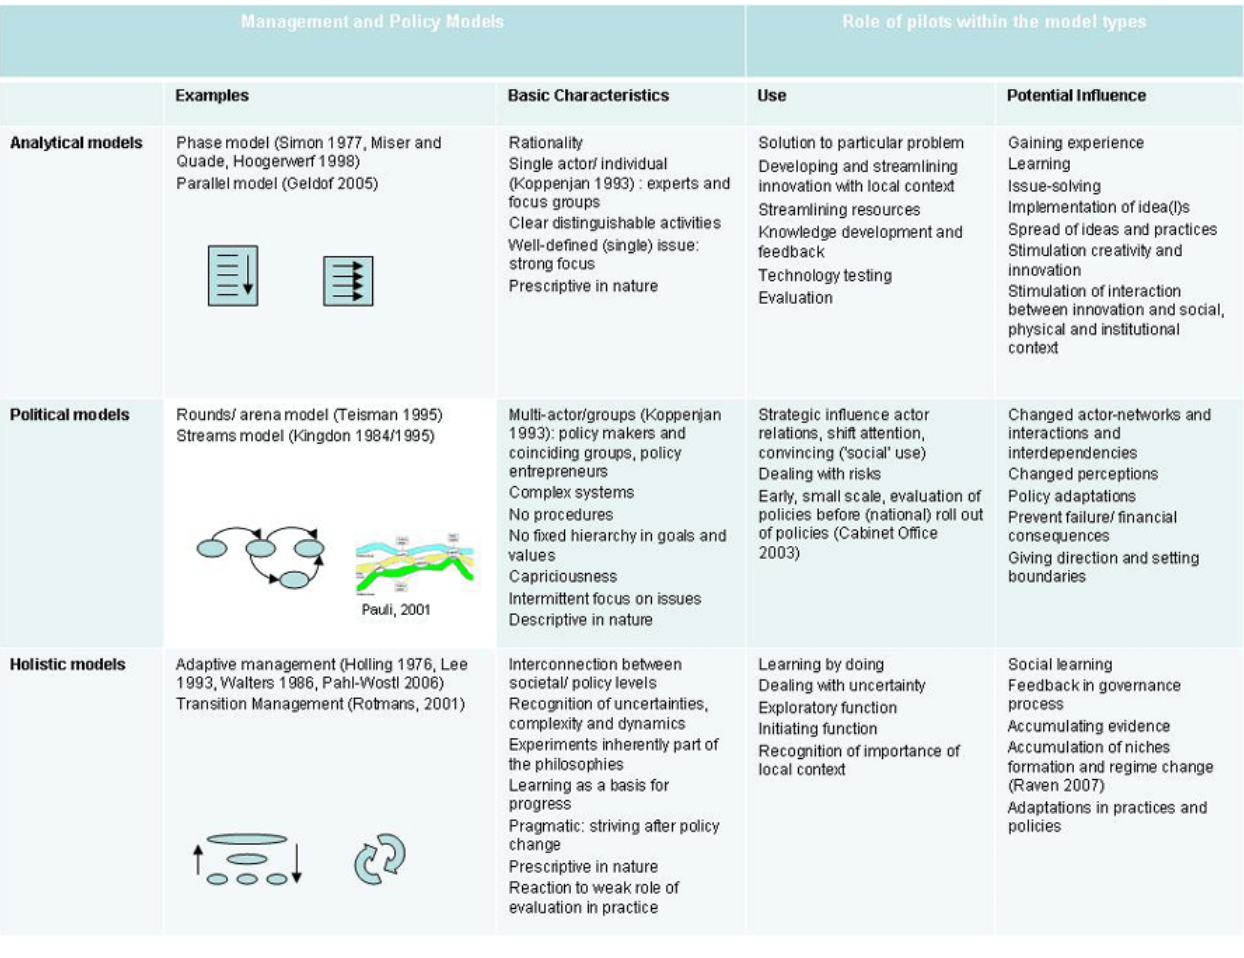
Fig. 1 . The role of pilot projects in policy development